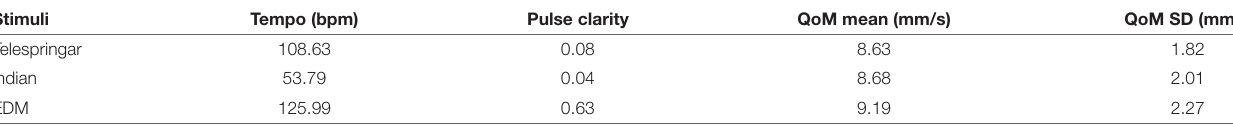
Model 11 had the smallest BIC number indicating better model adequacy. TABLE 2 | Average music and motion features for each of the presented stimuli.